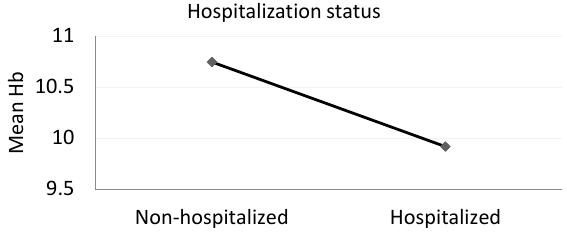
Figure 7. Association between hemoglobin level and hospitalization.